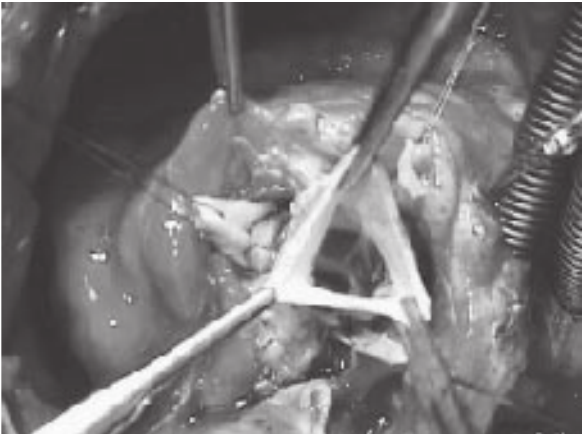
Fig. 1 - Aspecto operatório do implante de homoenxerto aórtico pela substituição total da raiz